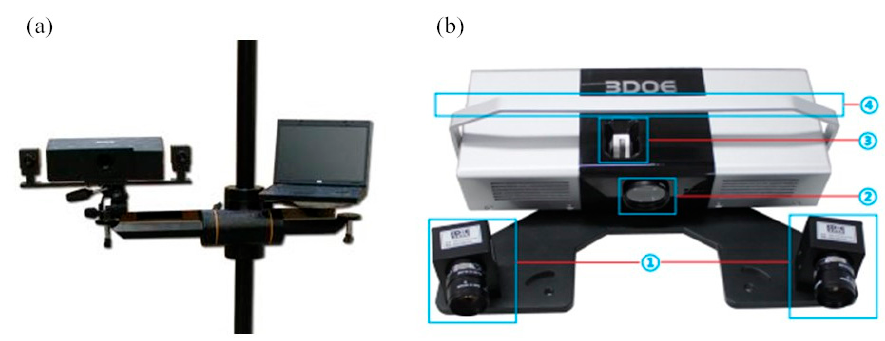
Figure 3. The PTS series 3D scanning system: ( a ) Overall picture of the scanning system; ( b ) overall picture of the scan head. 1. camera; 2. grating emitter; 3. raster transmitter adjustment button; 4. handle.